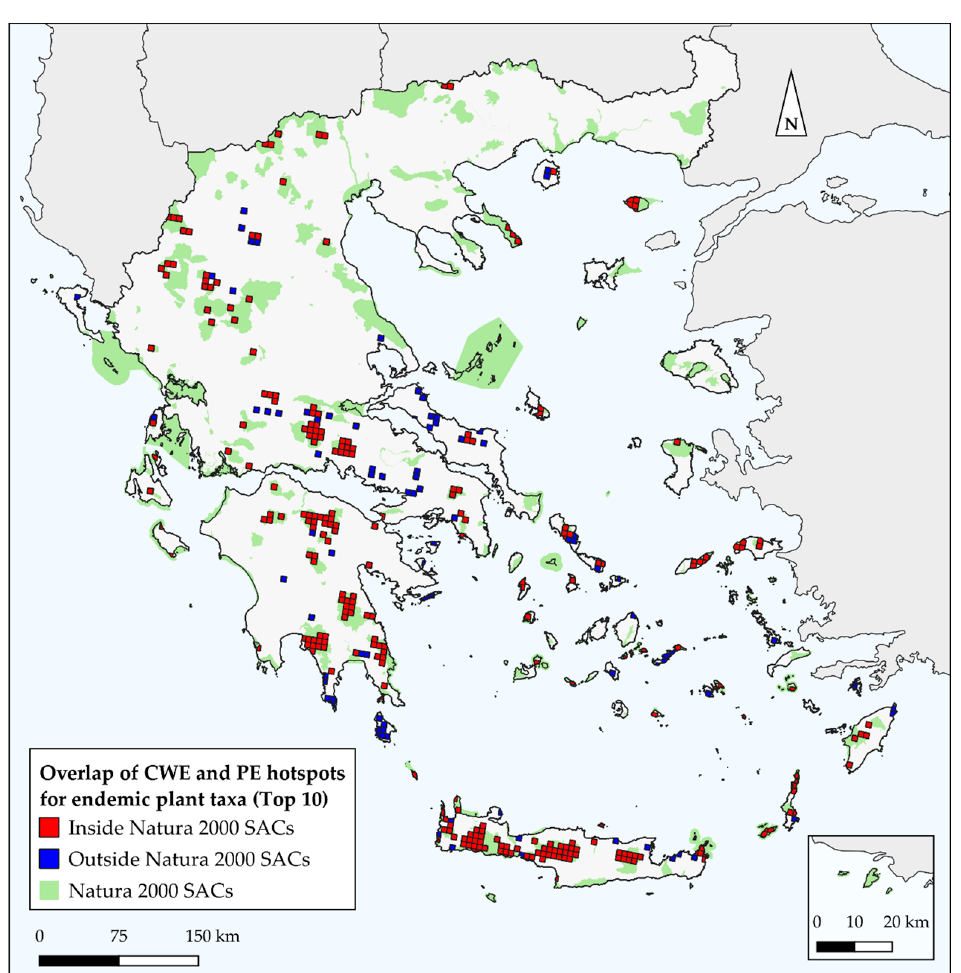
Figure 10. Red colouring indicates cells identified as Priority Hotspots with Level-3 (top 10%) CWE END and PE values that are inside the Natura 2000 SACs. Blue colouring indicates cells identified as Priority Hotspots with Level-3 (top 10%) CWE END and PE values that are outside the Natura 2000 SACs. Green polygons depict the Natura 2000 SACs in Greece.